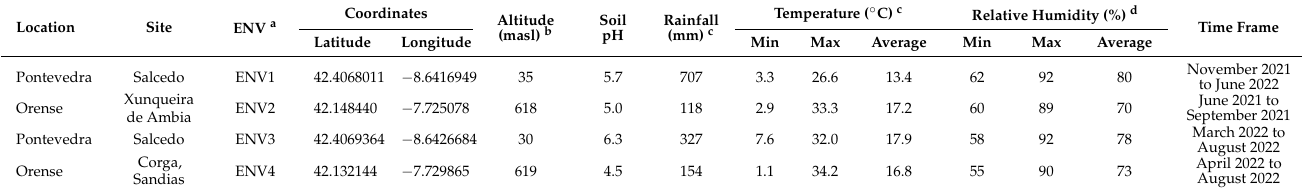
Table 1. Environmental characteristics of the locations during evaluations in 2021 and 2022 under winter and spring sowing